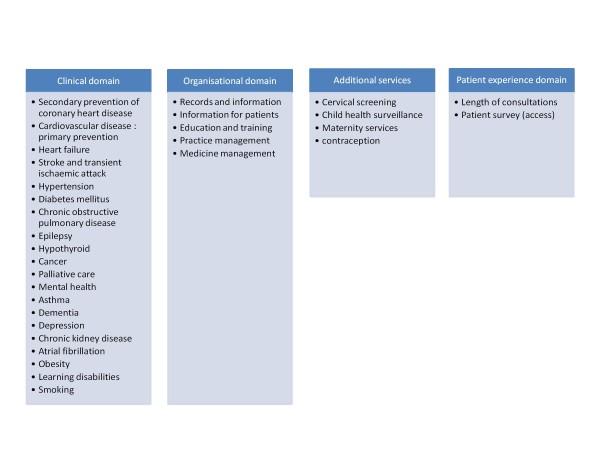
Domains of the QOF (2009) [64].